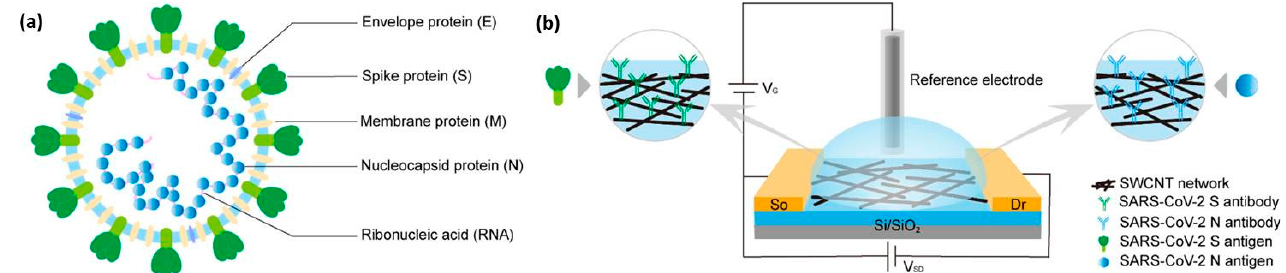
Figure 2. The detection of SARS-CoV-2 Ag using SWCNT-based FET biosensors. ( a ) Schematic structure of SARS-CoV-2 to demonstrate the targeting proteins. ( b ) Schematic illustration of a liquid-gated SWCNT FET for the detection of SARS-CoV-2 SAg and NAg. Interdigitated gold electrodes (yellow blocks) are configured as the source (So) and drain (Dr). (Reproduced with permission from Ref. [26]).